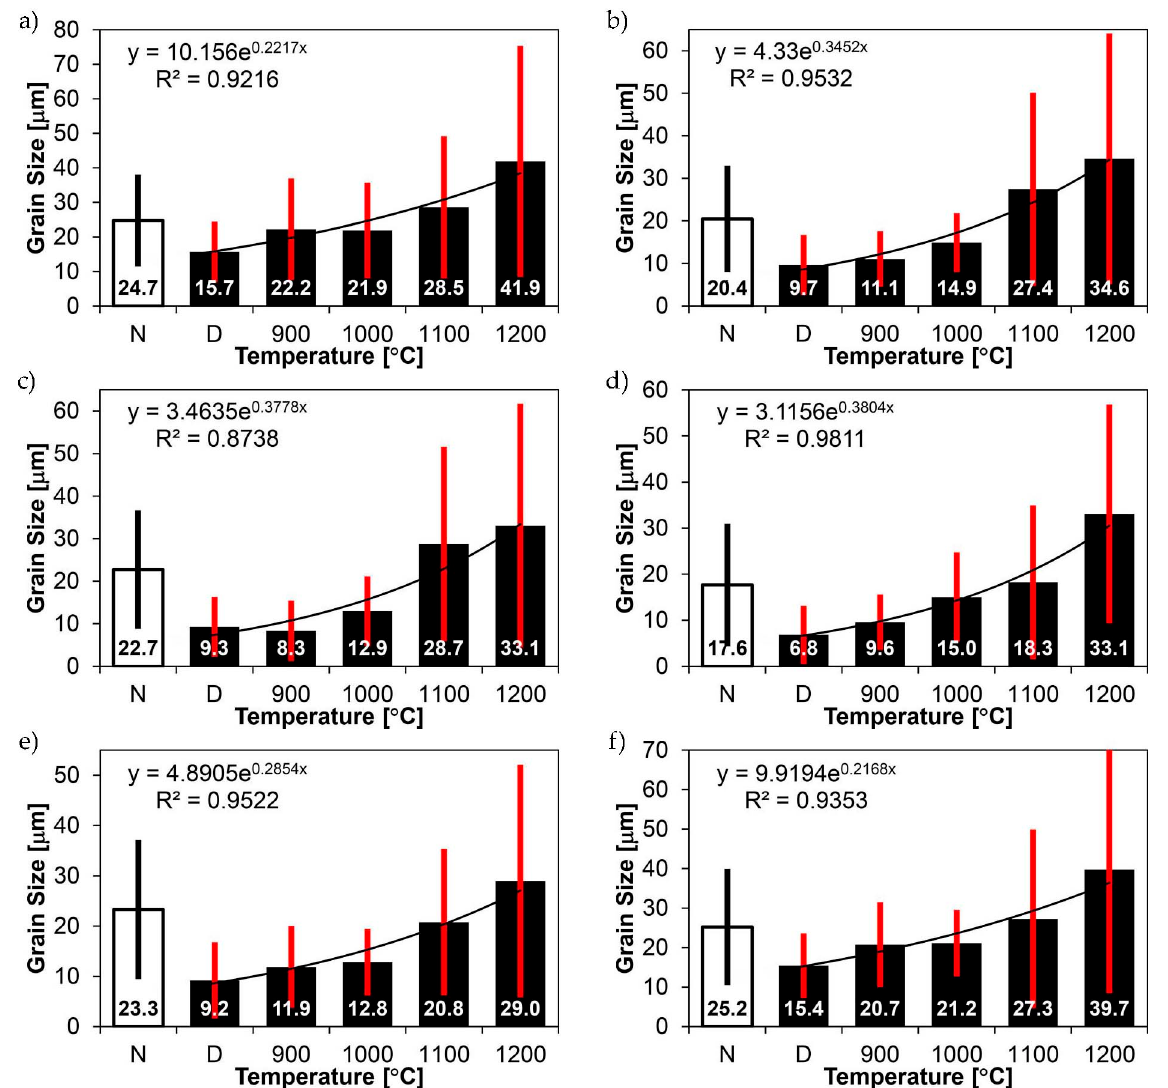
Figure 64. Juxtaposition of prior austenite average grain sizes as a function of temperature for individual weld zones of Hardox 450 steel shown in Figure 2: ( a ) parent material zone—BM; ( b ) weld metal zone—WM1; ( c ) weld metal zone—WM2; ( d ) weld metal zone—WM3; ( e ) fusion line—FL; ( f ) heat-affected zone—FGH(HAZ); N—normalised state, D—delivery state (directly after welding).